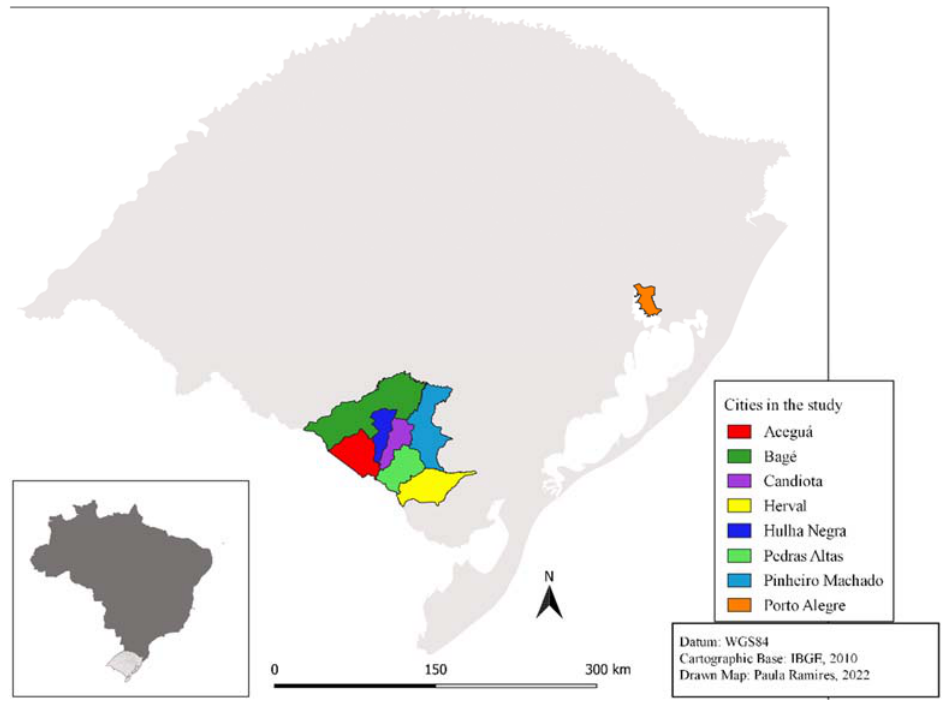
Figure 1. Map of the state of Rio Grande do Sul highlighting the cities involved in the study.